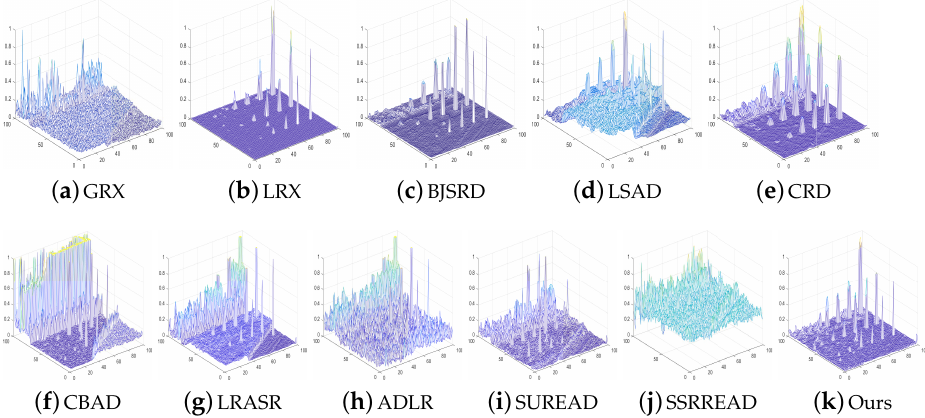
Figure 8. 3-D mesh of the detection algorithms for the simulated dataset.